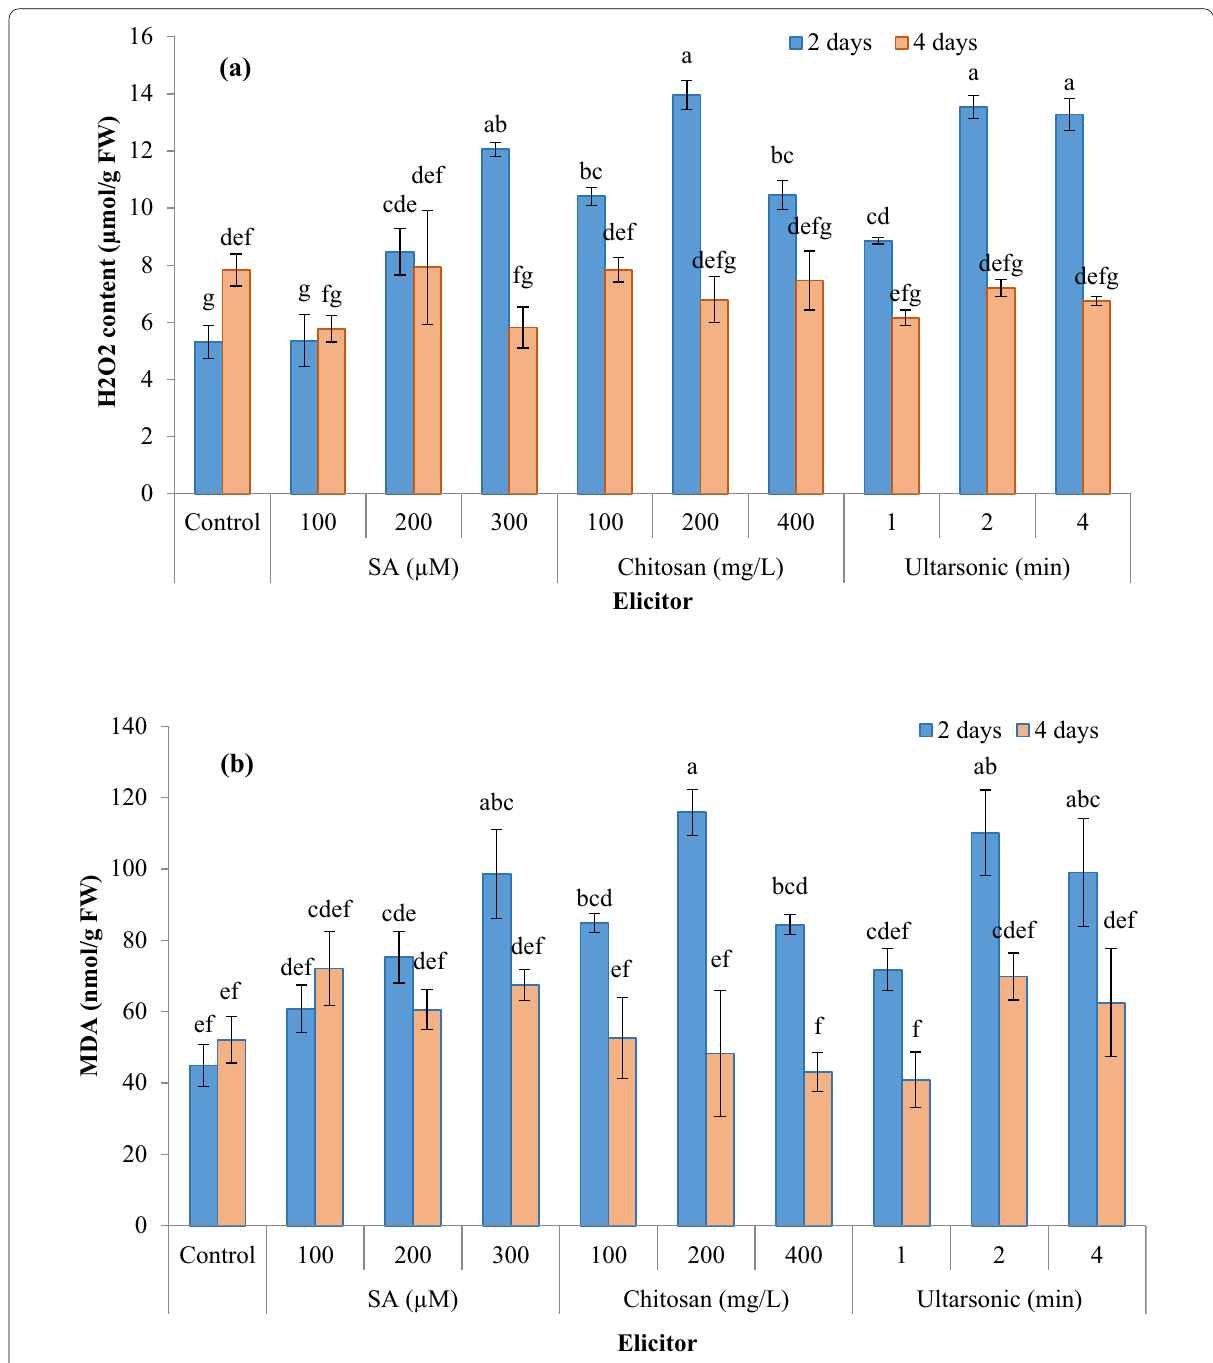
Fig. 6 Effect of different elicitors on H 2 O 2 ( a ), and MDA ( b ) in hairy root culture of G. officinalis . Different letters show significant differences ( p < 0.01) among